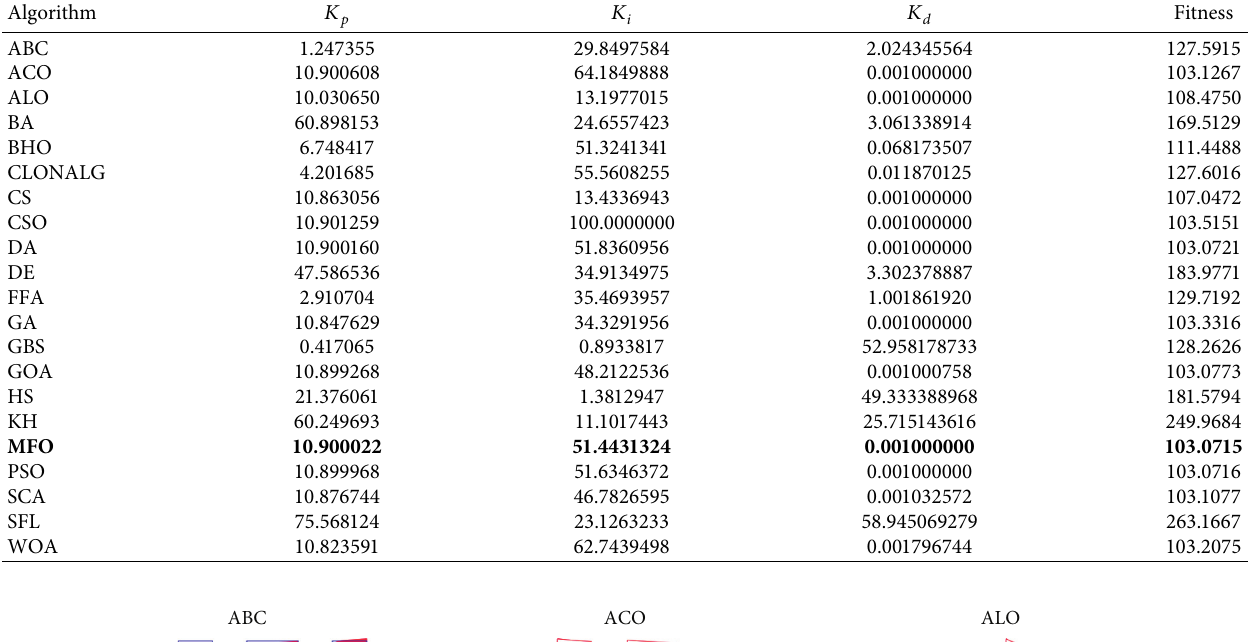
Table 6: Optimization solution values using proposed metaheuristics, using fitness f